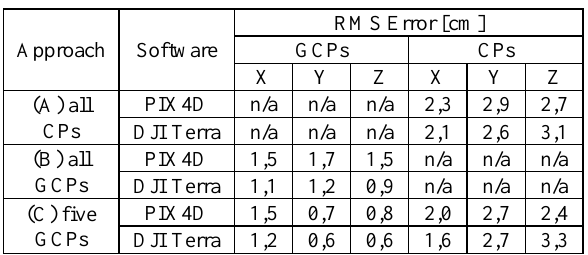
Table 3 . RMS error for GCPs and CPSs referred to the three different approaches followed using the two